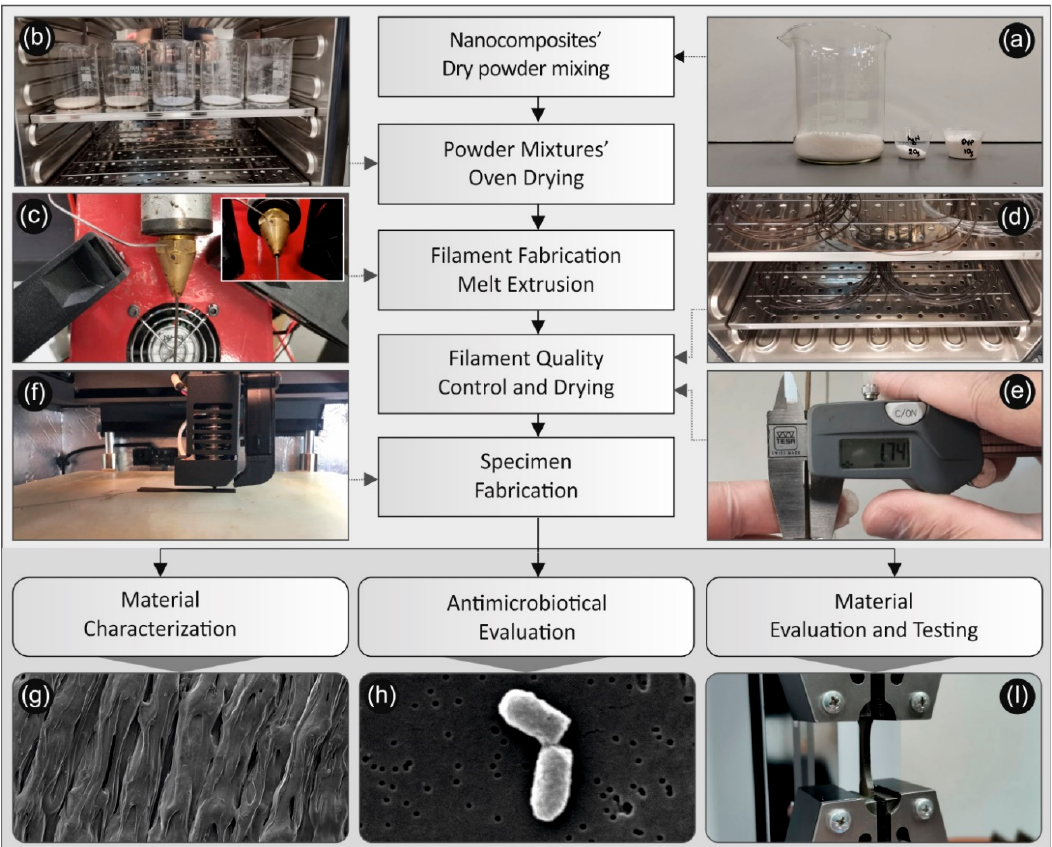
Figure 1. Schematic illustration for the process followed for the creation of poly-Lactic Acid (PLA)/silver nanoparticle (AgNP) nanocomposite filaments, for their characterization as well as the study of their antimicrobial and mechanical properties: ( a ) PLA, AgNO 3 and PEG or PVP (reducing agents) powders used for the reactive melt mixing, ( b ) the drying process of the powders/ materials before the reactive melt mixing process, ( c ) the PLA/AgNP filament fabrication via melt extrusion process, ( d ) the drying process of the produced PLA/AgNP nanocomposite filaments, ( e ) measurement of the produced filament diameter to be used for the FFF 3D printing process, ( f ) 3D printing FFF process for the manufacturing of the samples, ( g ) SEM image of the 3D printed samples’ side surface showing the additively 3D printed layers of the samples, ( h ) SEM typical image of bacteria attached onto the samples surface after di ff erent durations in contact with the antibacterial 3D printed samples used in the antibacterial tests carried out in this work, ( i ) 3D printed dog bone-shaped sample during tensile